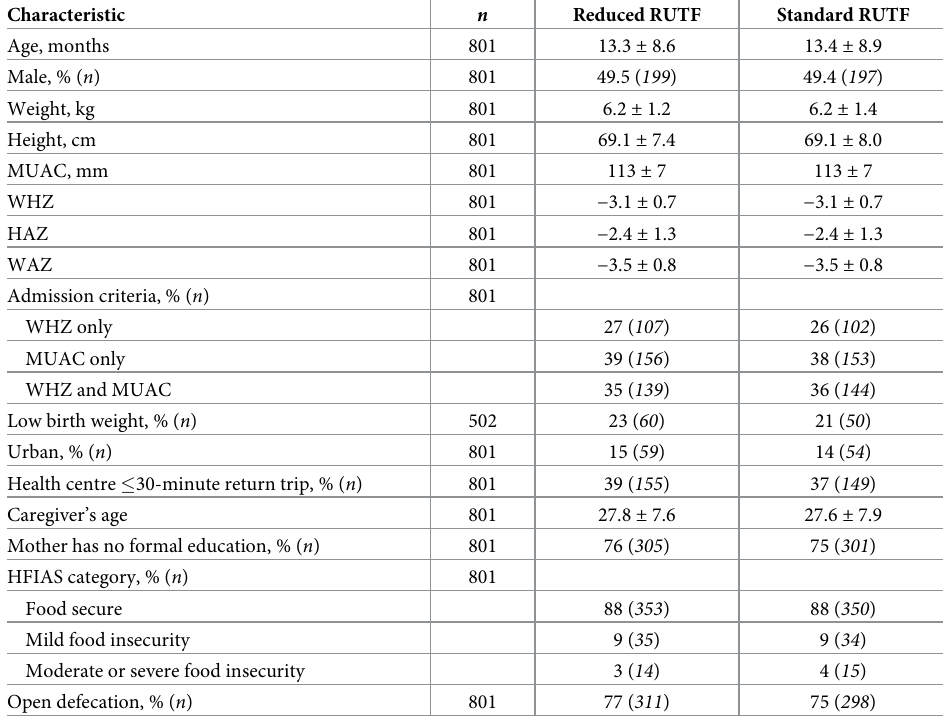
Table 2. Baseline characteristics of 801 children with SAM, randomised to reduced or standard RUTF dose. Characteristic n Reduced